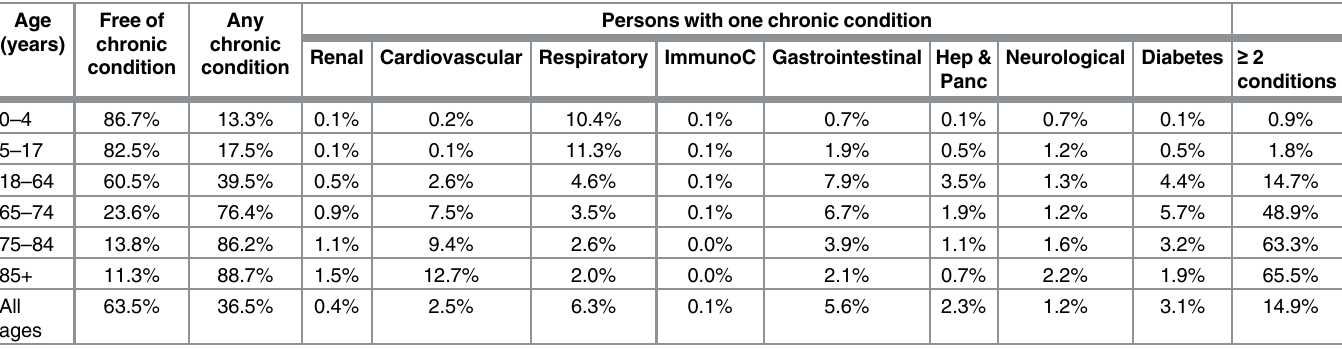
Table 3. Proportion of the total population found to be free of any chronic medical condition, to have any of the chronic medical conditions included, to have only one chronic medical condition (per group of conditions) and more than one chronic medical condition in the MarketScan population between 2002 and 2013, per age group and